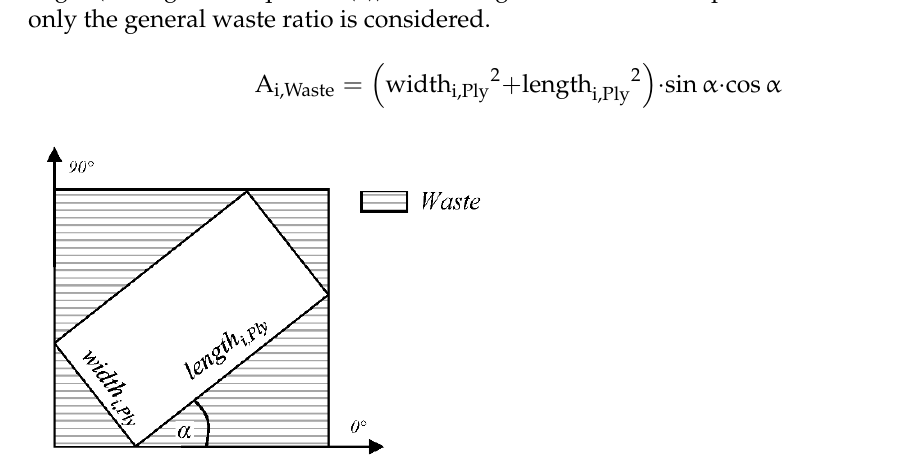
Figure 7. Calculation of material waste area for rectangular shapes for fiber angle α , depending on the width and length of an FRP layer.